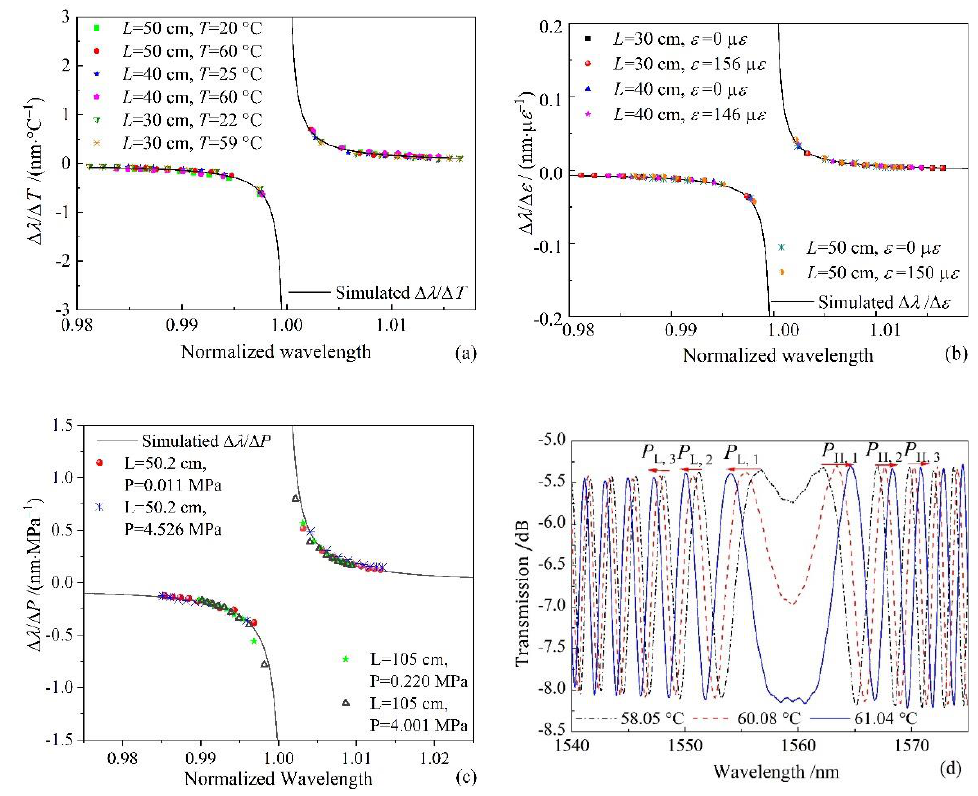
Figure 4. Characteristics of interference fringes in the transmission spectra of the CWL-existed SFS structure: ( a ) temperature wavelength sensitivities of interference fringes; ( b ) axial strain wavelength sensitivities of interference fringes; ( c ) static pressure wavelength sensitivities of interference fringes; ( d ) transmission spectra of the SFS structure ( L FMF = 50 cm) under temperature variations.